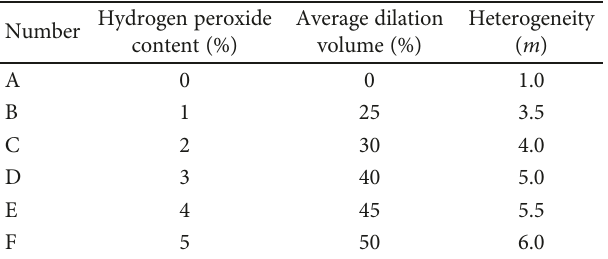
Table 1: Relationship between initial porosity and the heterogeneity parameter of the specimen.